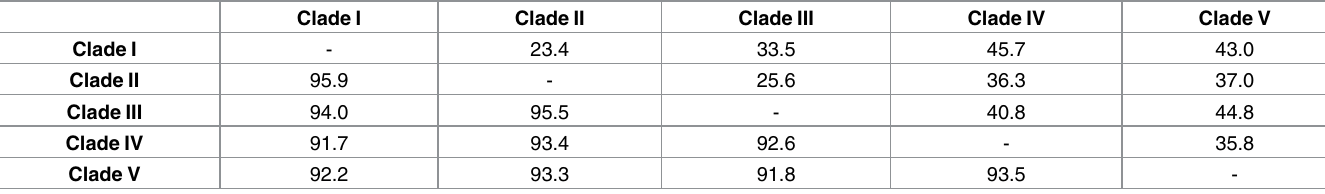
Table 2. Similarities (%) and number of ITS sequence differences among five clades in section Halophila .